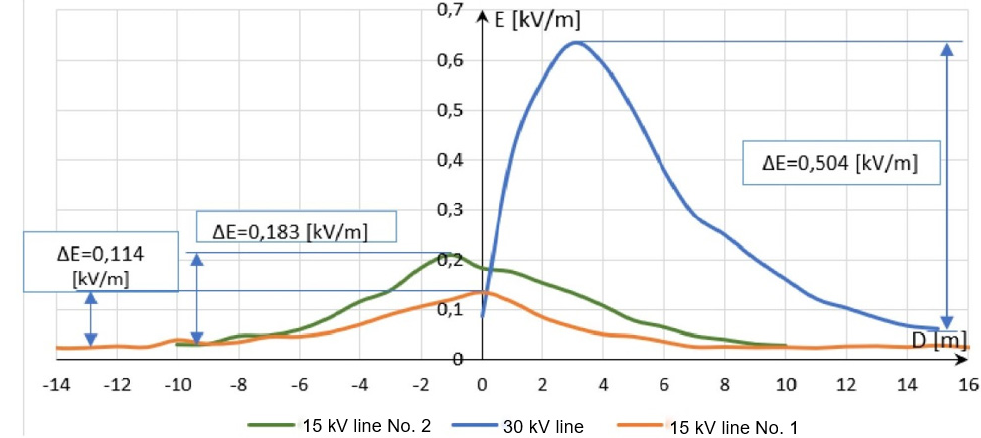
Figure 12. Distribution of electric field strength E across the line, for measuring point No. 3 and the ELF frequency range (induction measuring methodology as in Figure 2).